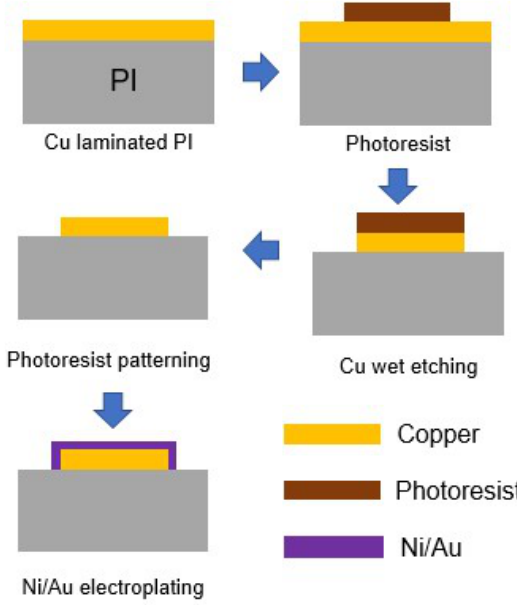
Figure 2. Fabrication process of the flexible substrate.